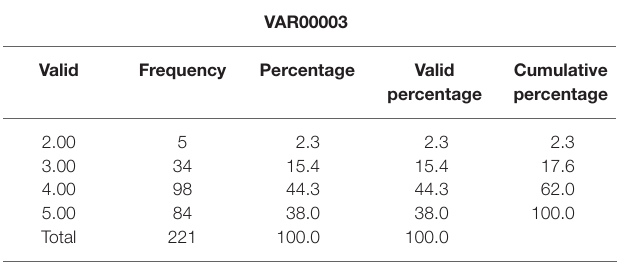
TABLE 3 | Activity has improved my motivation to make more effort in the subject.